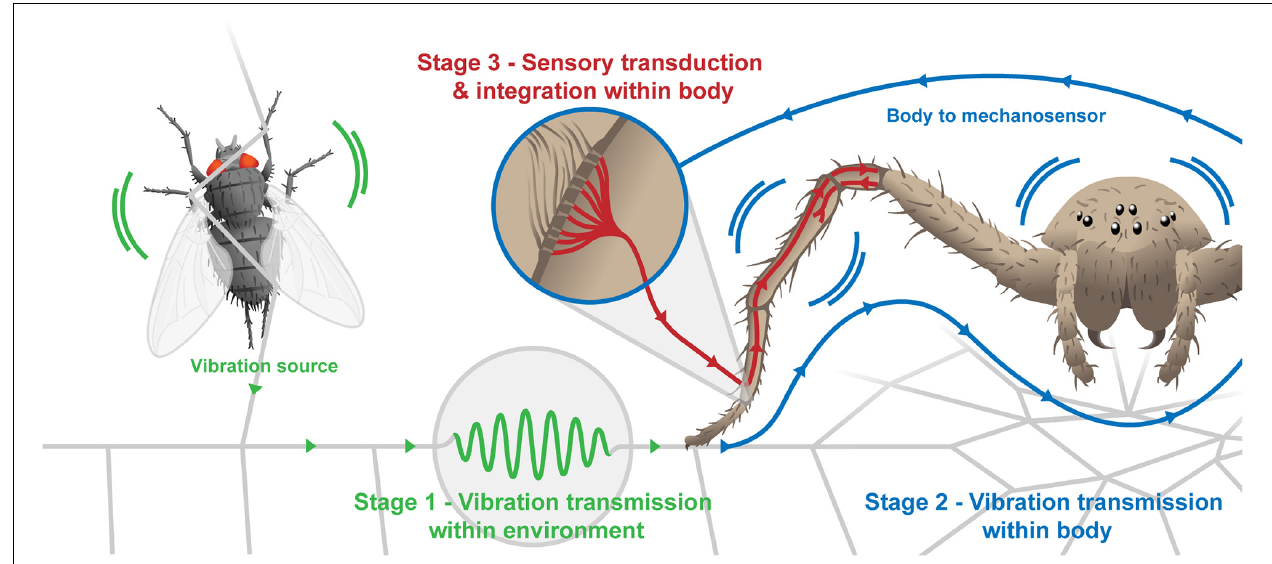
FIGURE 1 | diagrammatic representation of the stages in vibration sensing detailed in Table 1 . Stage 1—transmission from source of vibration through environmental substrates (in this case the web) to the body. Stage 2—body transformation of input wave before it reaches the mechanosensor (lyriform organ shown in insert). Stage 3—sensory transduction of vibrational information, which feeds back to determine behavior, in turn influencing Stages 1 and